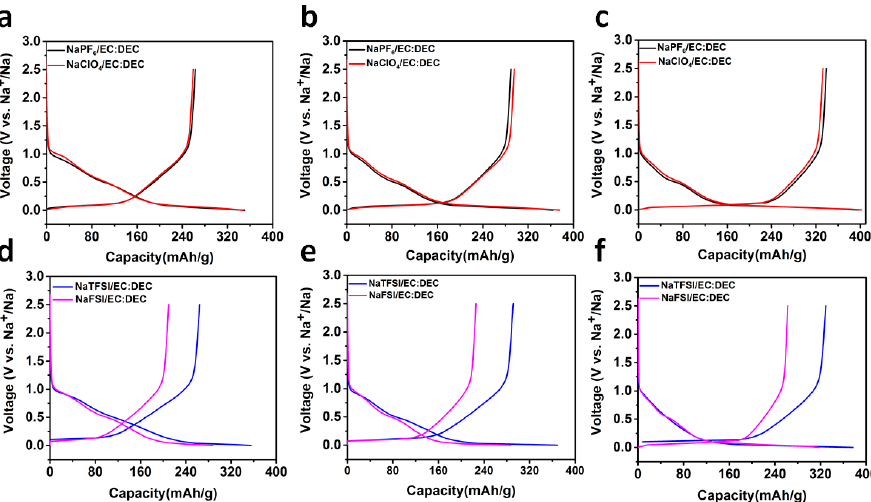
Figure 3. Storage performance of half-cells in different electrolytes. Discharge/charge curves with NaPF6/EC:DEC and NaClO4/EC:DEC electrolytes: ( a ) HC-1000; ( b ) HC-1200; and ( c ) HC-1400. Discharge/charge curves with NaTFSI/EC:DEC and NaFSI/EC:DEC electrolytes: ( d ) HC-1000; ( e ) HC-1200; and ( f ) HC-1400.